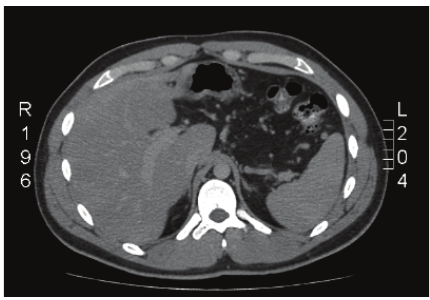
Figure 2: Left branch of the portal vein not seen, likely obstructed by a thrombus (only the right branch is